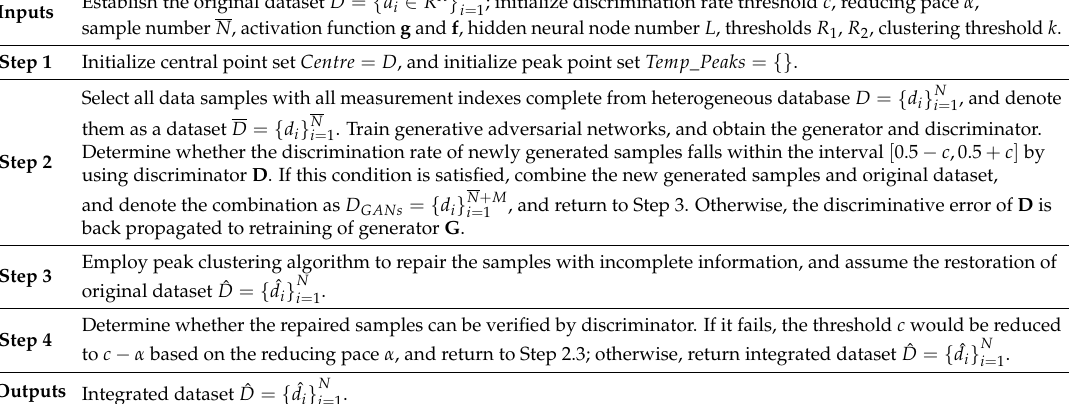
Table 2. GANs Based Heterogeneous Data Integration.